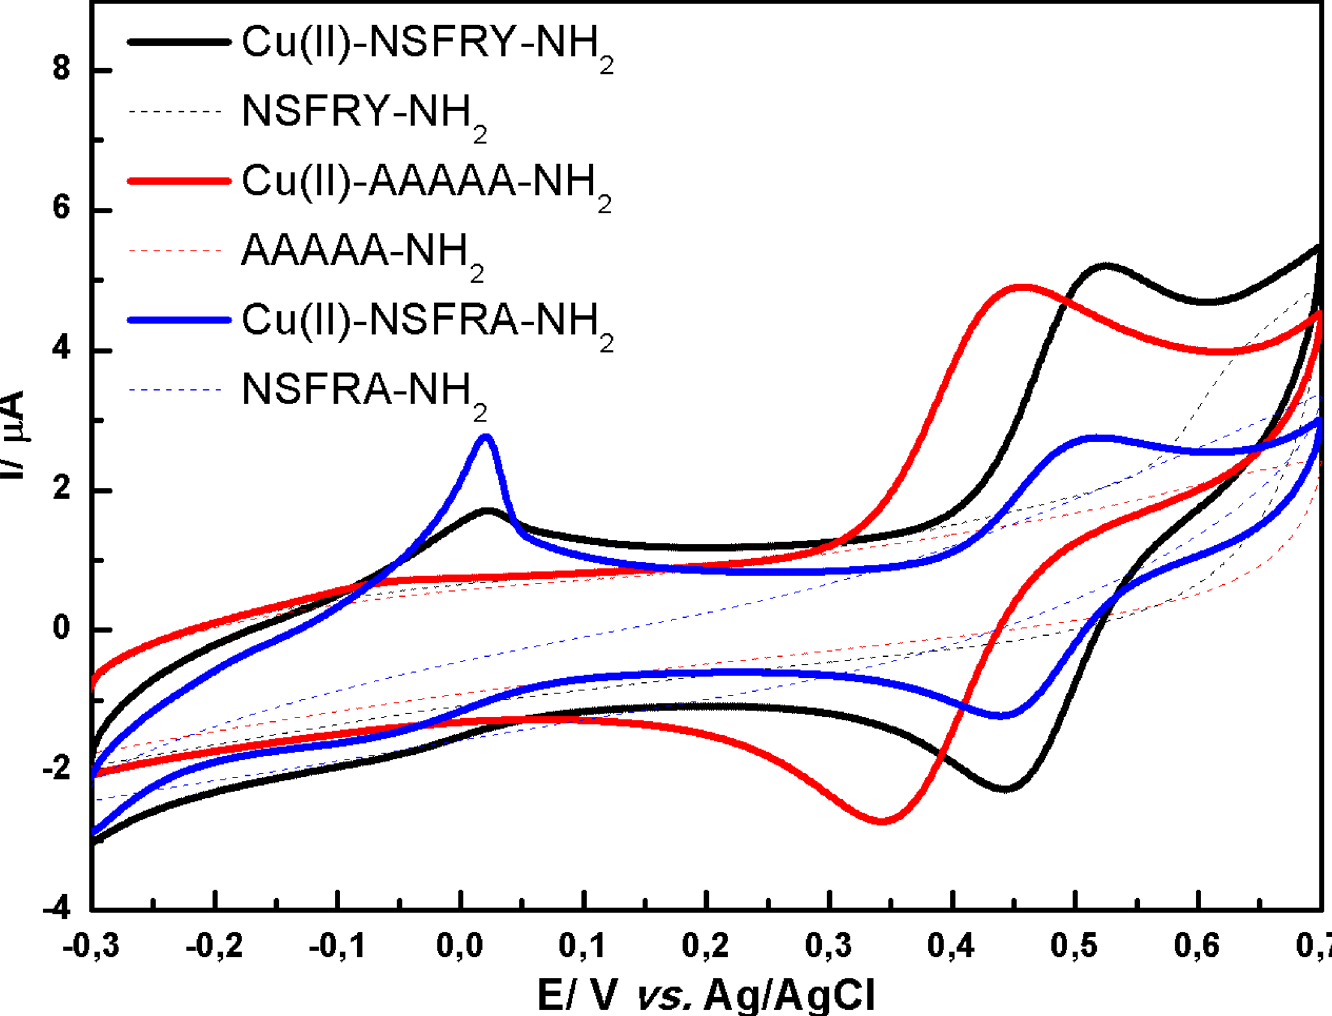
Fig 4. Cyclic voltammograms recorded in 0.5 mM aqueous solution of Cu(II)-NSFRY-NH 2 complex (black solid line) and NSFRY-NH 2 peptide (black dashed line) at pH 6.7; Cu(II)-AAAAA-NH 2 complex (red solid line) and AAAAA-NH 2 peptide (red dashed line) at pH 8.0; Cu(II)-NSFRA-NH 2 complex (blue solid line) and NSFRA-NH 2 peptide (blue dashed line) at pH